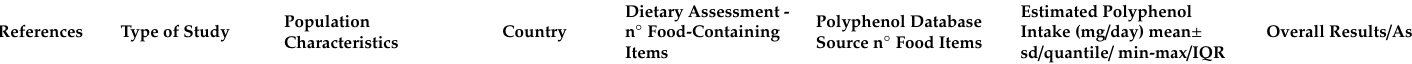
Table 3. Association between polyphenol intake and all-cause / cardiovascular